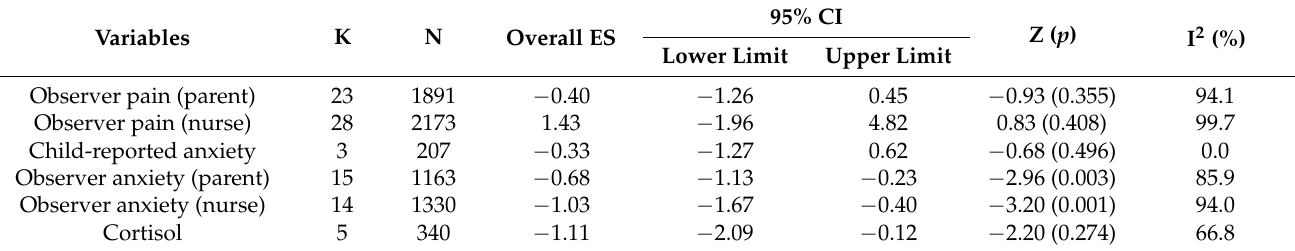
Table 3. The effect of distract intervention on distress of the